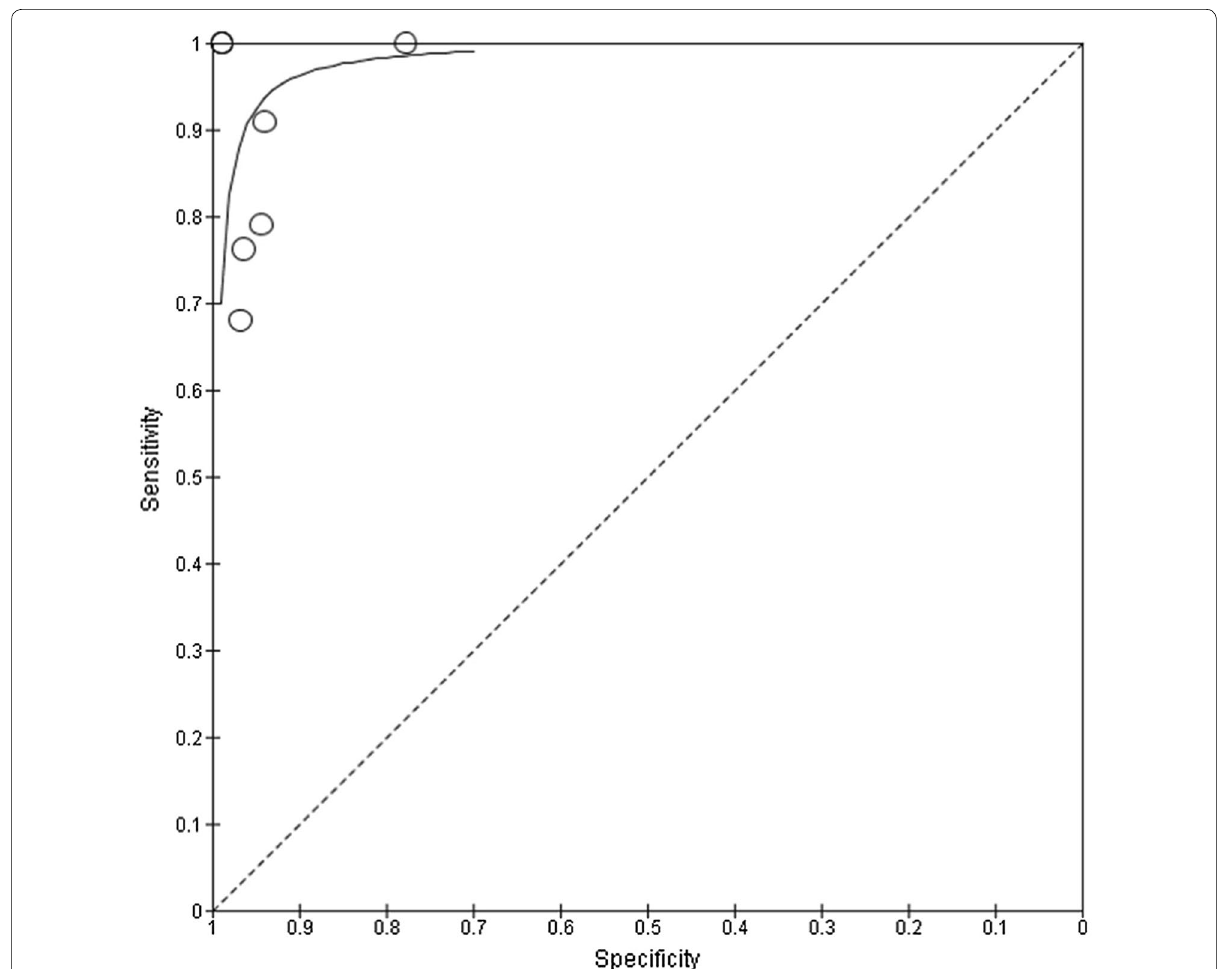
Fig. 3 Summary receiver operating characteristic plot. Each circle represents the sensitivity and specificity estimate from one